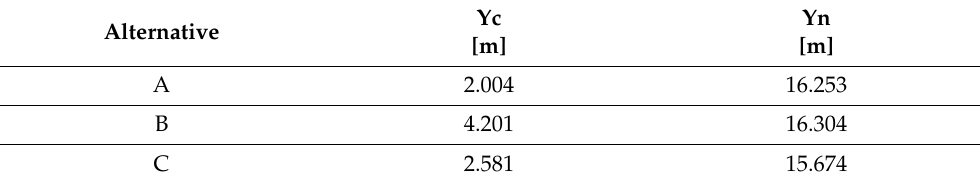
Figure 6. ( a ) Probability distribution functions (PDF) and ( b ) cumulative distribution functions (CDF) at the Vinces station. Table 4. Critical depth (Yc) and Normal depth (Yn) for alternatives A, B, and